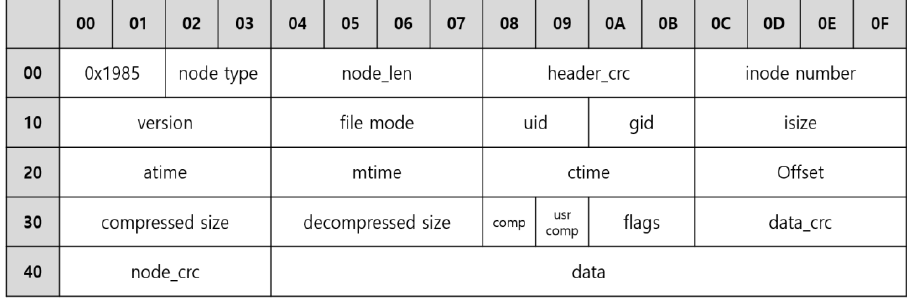
Figure 11. JFFS2 inode structure in form of hex value.